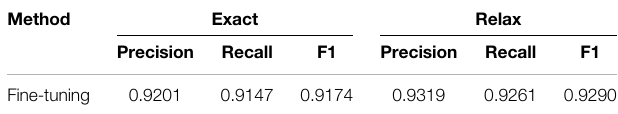
TABLE 3 | Performances of end-to-end systems for chemical reaction extraction. Both exact and relaxed matching results are